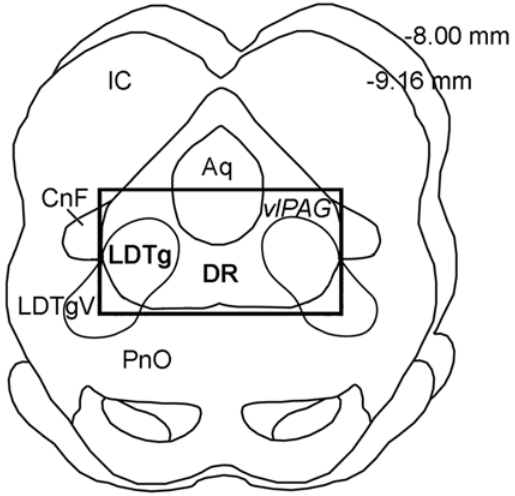
Fig 1. Area of Tissue Dissection for Molecular Experiments. Schematic drawing illustrates rat transverse midbrain section at the level of the inferior colliculus ( IC ). It corresponds to Plates 52 – 56 of the adult rat brain atlas [31]. Rectangle encloses area dissected for the isolation of the tissue used in molecular experiments. It includes laterodorsal tegmental nucleus ( LDTg ) of the ventrolateral periaqueductal gray ( vlPAG ) and dorsal raphe ( DR ). Numbers in the upper right corner illustrate distance from Bregma. Abbreviations : Aq , aqueduct (Sylvius); CnF , cuneiform nucleus; LDTgV , laterodorsal tegmental nucleus, ventral part; PnO , pontine reticular nucleus, oral